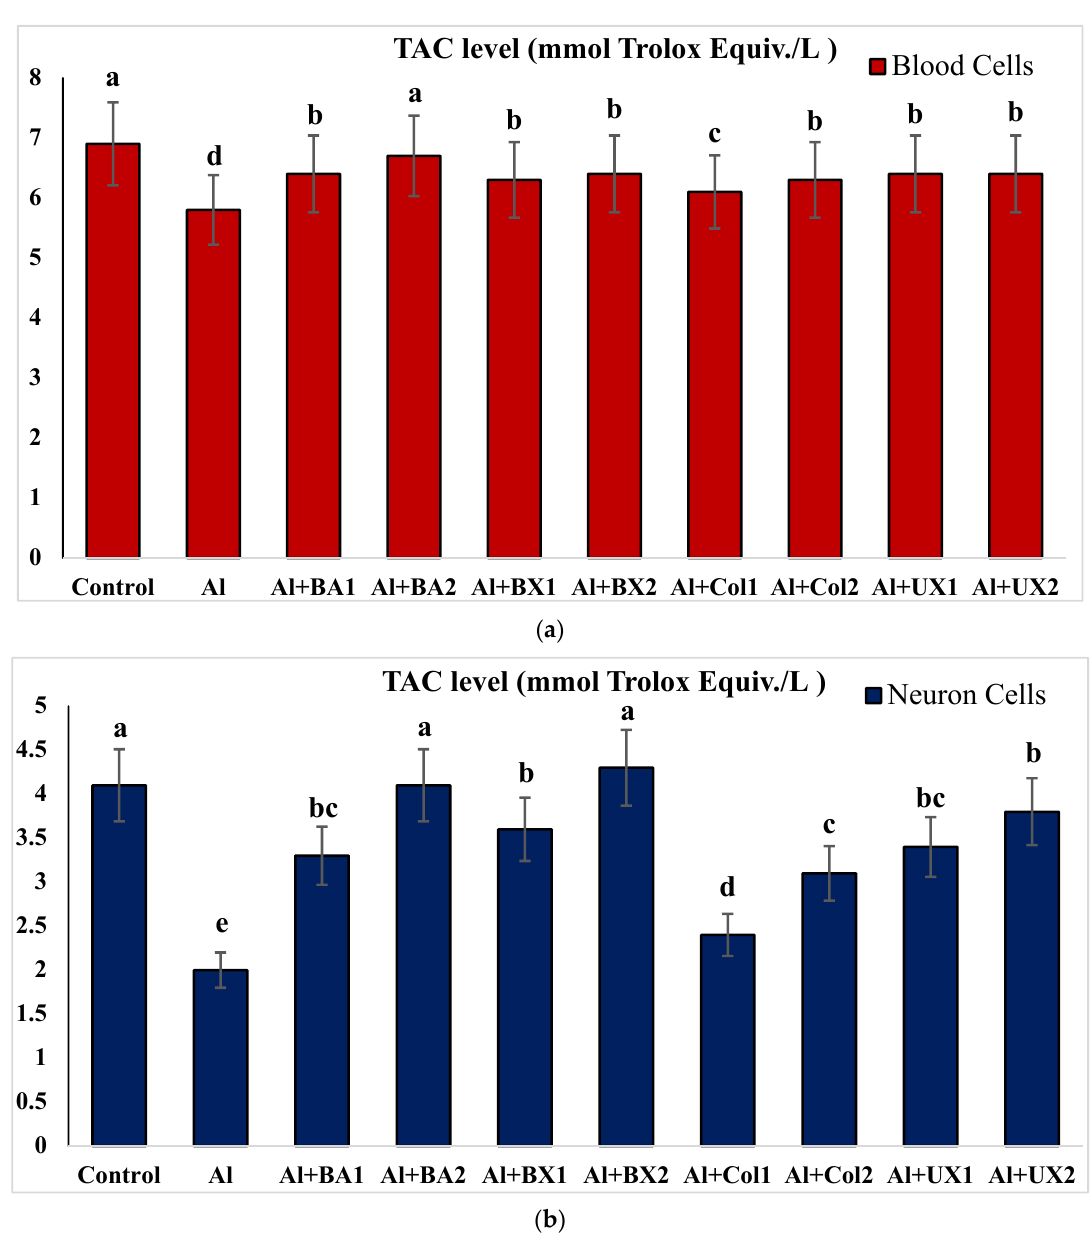
Figure 4. The effect of Al and boron treatments in ( a ) human blood and ( b ) PRCNs on GSH-Px activity. Abbreviations are as in Figure 2. (Each superscript letter (a, b, c) represents statistically similar groups).